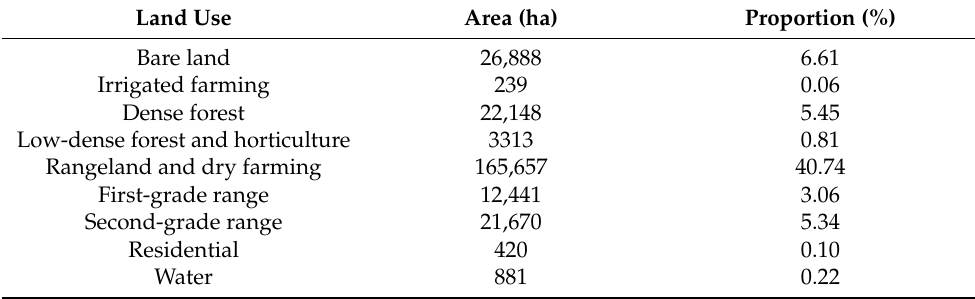
Table 4. Area of unchanged land use between 1996 and